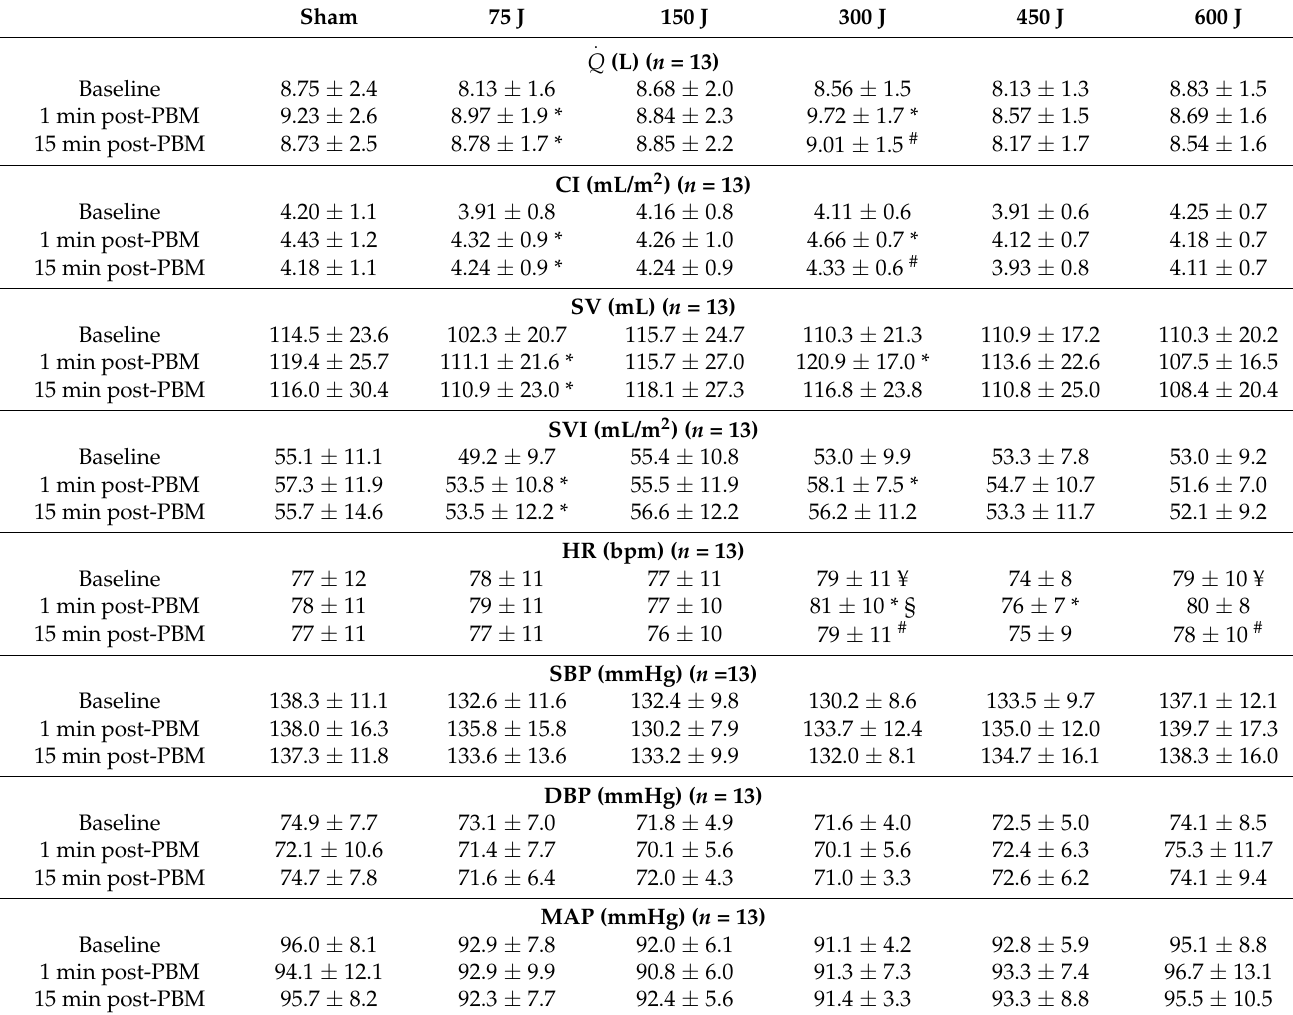
Table 4. Mean and standard deviation of hemodynamic variables at baseline, 1 min and 15 min post-PBM for sham energies, 75, 150, 300, 450, and 600